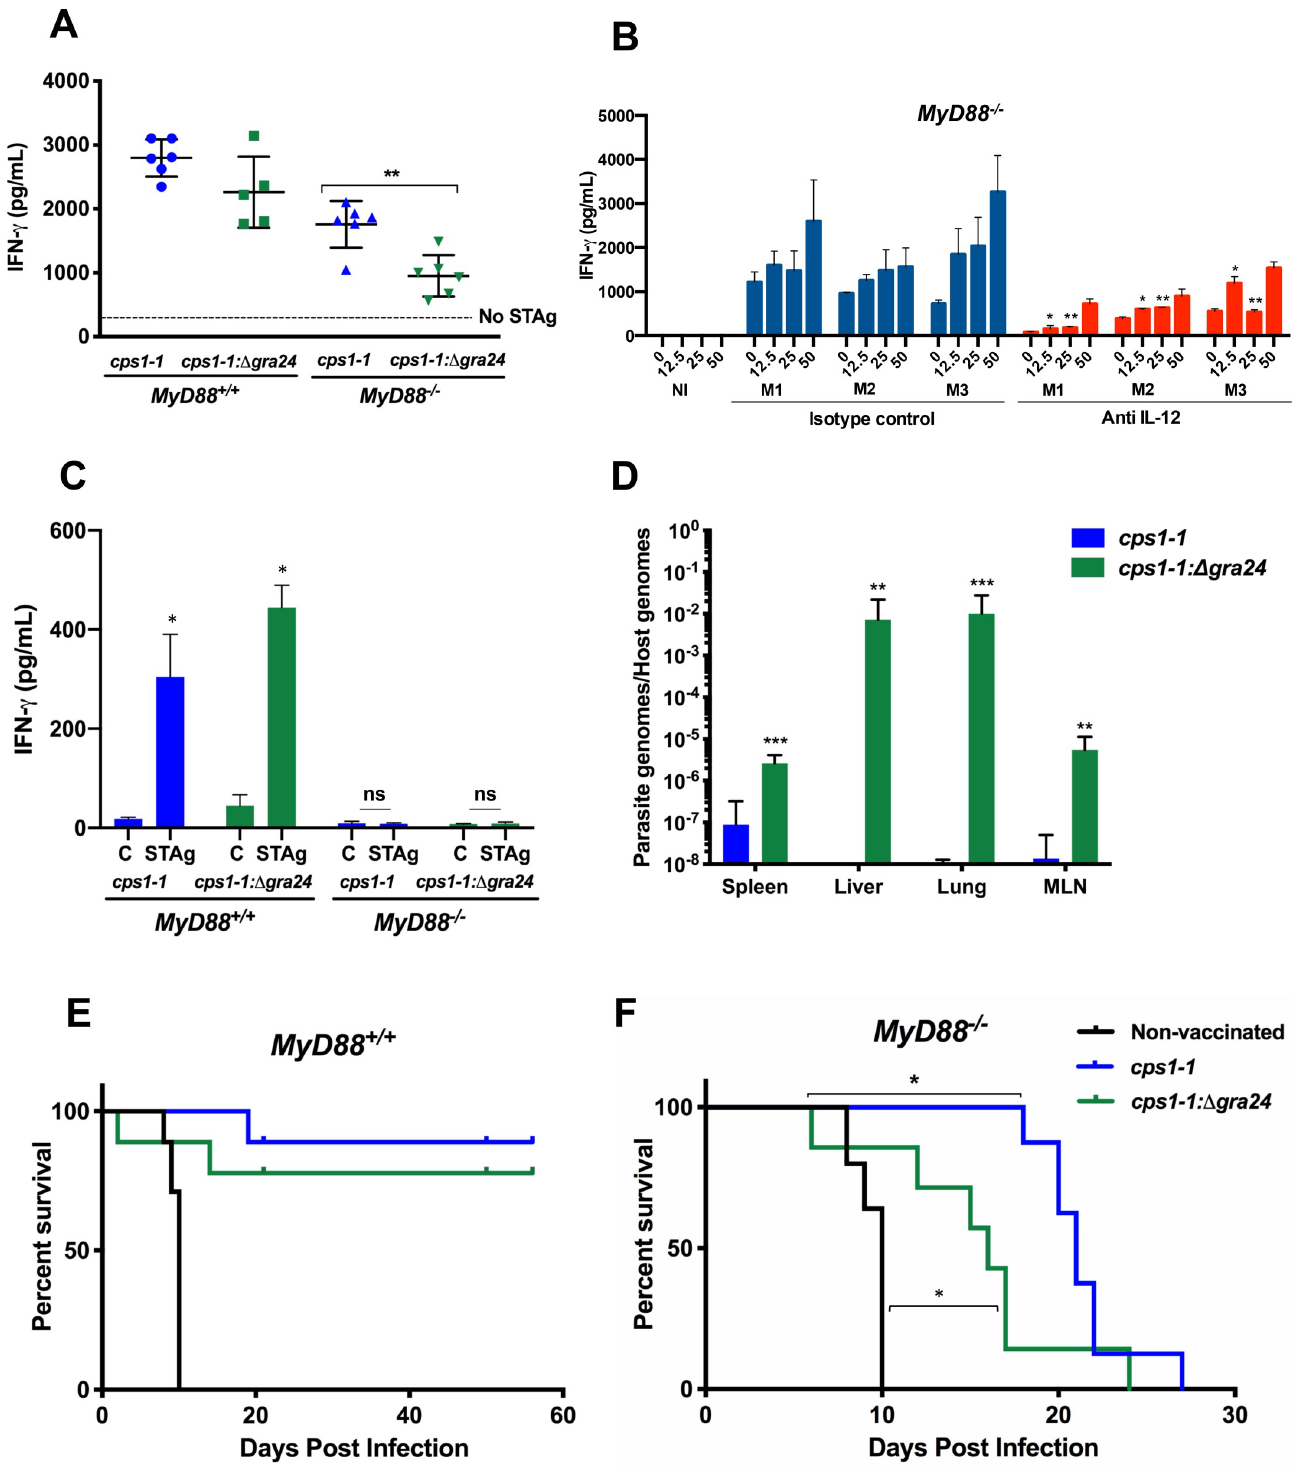
Fig 6. GRA24 induces protective immunity in the absence of MyD88. ( A ) MyD88 +/+ and MyD88 -/- animals (n = 5–6 mice per group) were i. p. inoculated at Day 0 and Day 14 with 10 6 cps1-1 or cps1-1 : Δ gra24 tachyzoites, then at day 28 splenocytes were isolated and subjected to in vitro stimulation with soluble tachyzoite antigen (STAg; 50 μ g/ml). Supernatants were collected at 72 hr for cytokine ELISA. Each point represents a single mouse. ( B ) MyD88 -/- mice (n = 3 mice per group) were administered IL-12 neutralizing antibody or isotype control antibody during the course of infection initiated by inoculation with 5 x 10 6